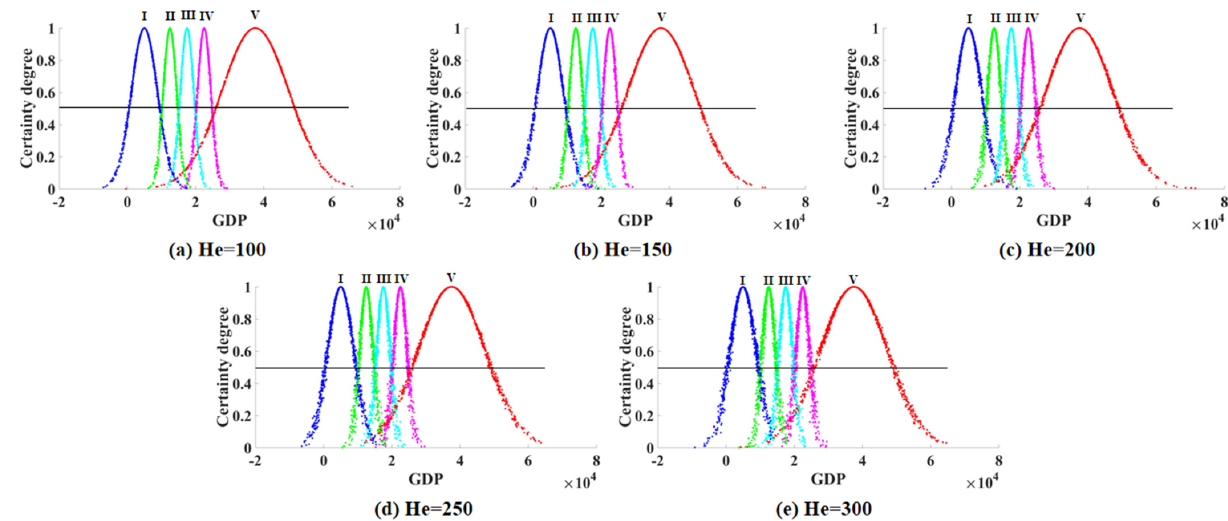
Figure 2. Cloud model map of GDP. Table 3. The Cloud Matter element Parameters of Urban Water Security Evaluation Standard.